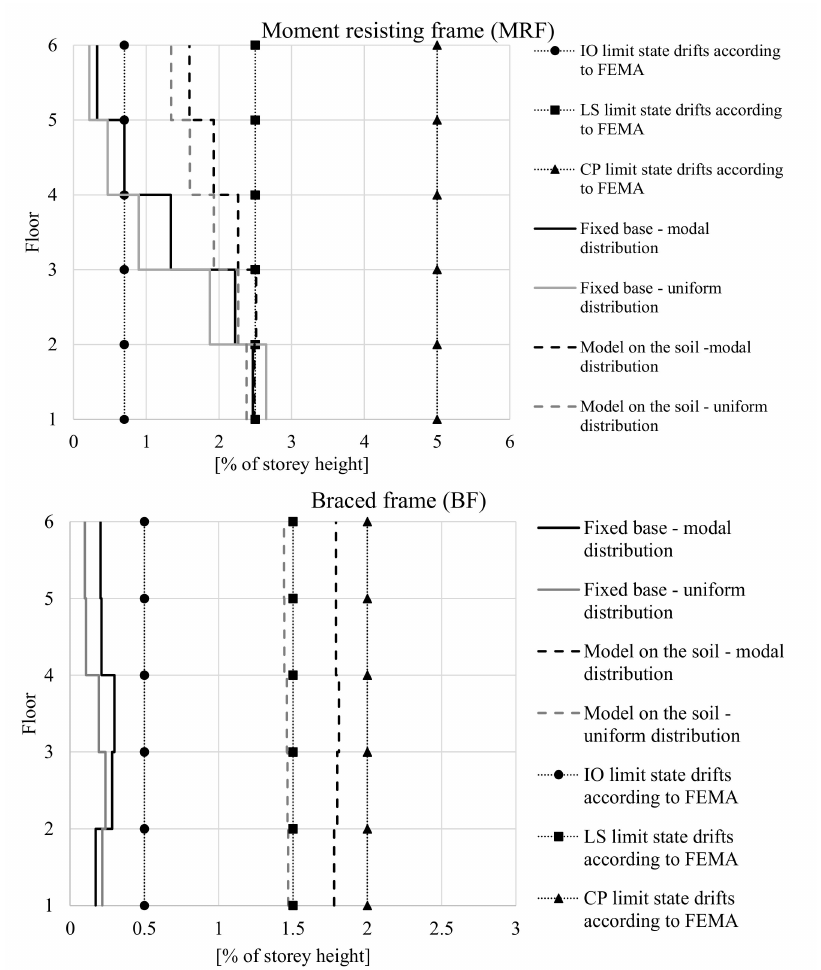
Figure 12. Comparison of the story drifts (PGA = 0.30 g).